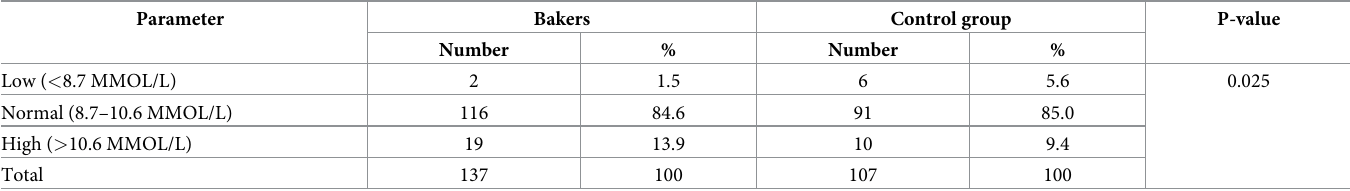
Table 2. Comparison of hemoglobin levels among the bakers and the control group.